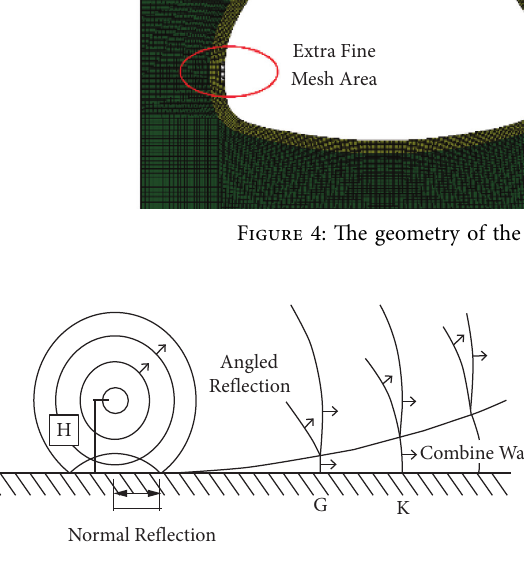
Figure 5: The schematic diagram of the generation of Mach wave reflection [10].